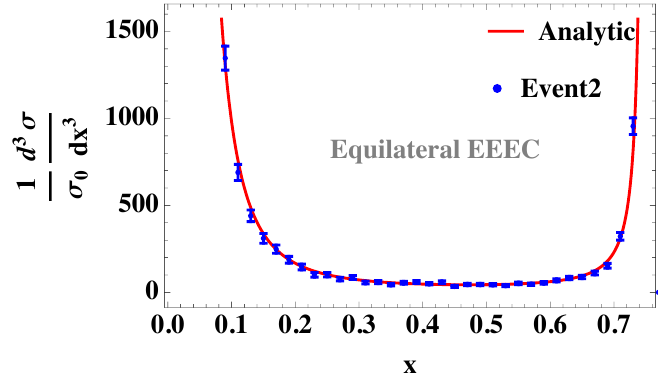
Figure 7 . The comparison between the analytic expression and Event2 for equilateral EEEC. We compute 2.5 billion events and set the internal cutoff to 10 − 14